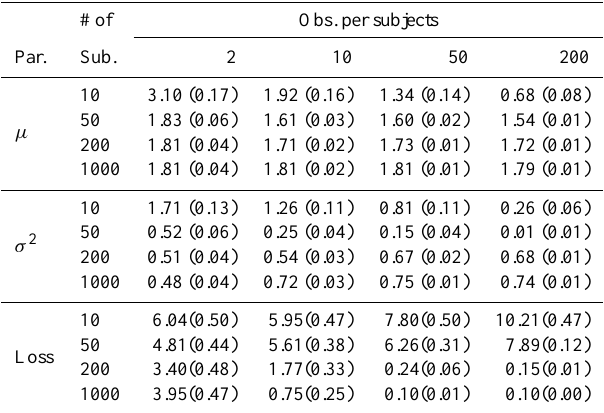
Table 3. glmer simulation results: µ = 2, σ 2 = 1. # of Obs. per subjects